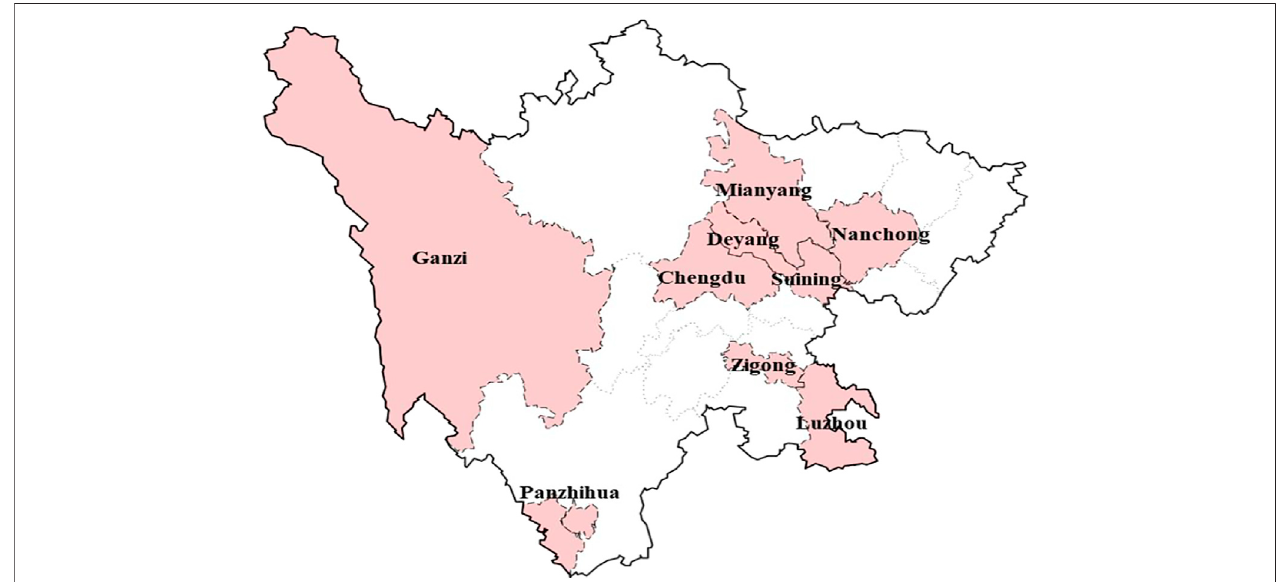
FIGURE 1 | Cities of Sichuan province included in the